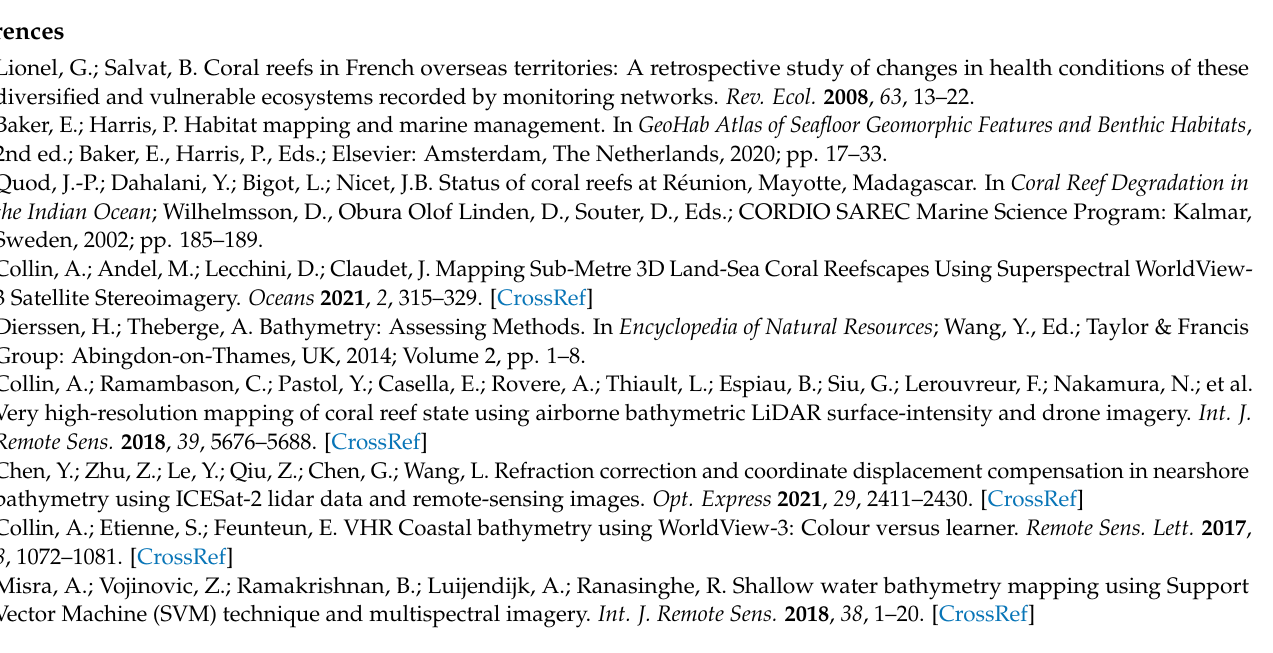
Figure A4. Evolution of the absolute error with depth on a transect far from the ICESat-2 ground track.